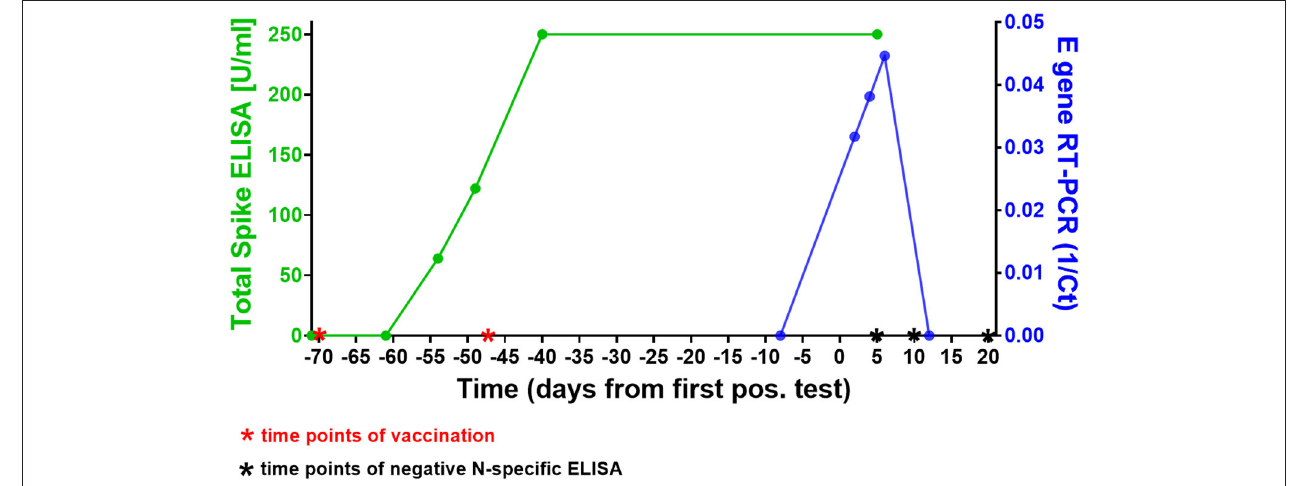
FIGURE 1 | Time course of SARS-CoV-2 vaccinations, antibody response, and infection in our subject. The green line shows the course of SARS-CoV-2 spike-specific antibodies in the patient. A first rapid antigen test was positive 49 days after the second vaccination, a first positive RT-PCR 2 days later. Note that 250 U/ml were the upper threshold value of the ELISA, the result for both data points in this assay was above the limit of accurate detection ( > 250 U/ml). The blue line shows the SARS-CoV-2 RT-PCR cycle threshold (Ct) value of the laryngopharyngeal swab samples taken from the patient on 5 different days around the time point of infection (results shown here for E gene Ct’s). Note that the first positive RT-PCR showed the lowest viral load (highest Ct) of all three positive tests. The Roche Elecsys ® N-specifc ELISAs performed on days 5, 10, and 20 days after first positive SARS-CoV-2 antigen test were negative at COIs 0.065, 0.46, and 0.569, respectively (threshold for positive result: 1.0), see also Supplementary Figure 1